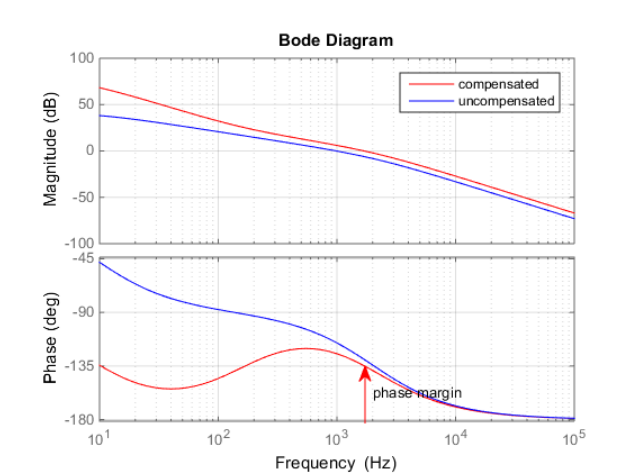
Fig. 3. Norton equivalent circuit